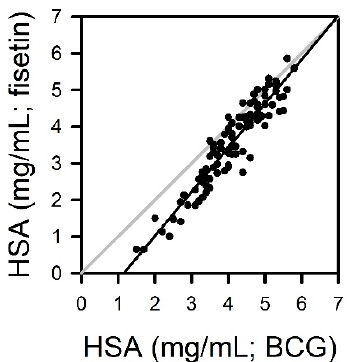
Figure 5. Quantitation of albumin in human sera from 100 donors using fisetin and BCG methods. The albumin concentrations were calculated from the calibration curves obtained with standard HSA. The measurements from the fisetin-based assay were plotted versus values from BCG methods.